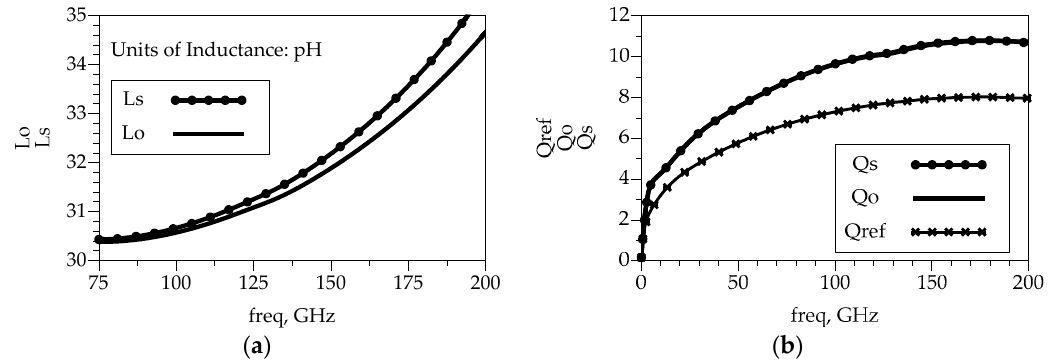
Figure 5. The curve of the inductance vs. frequency ( a ) and the Q vs. frequency ( b ).